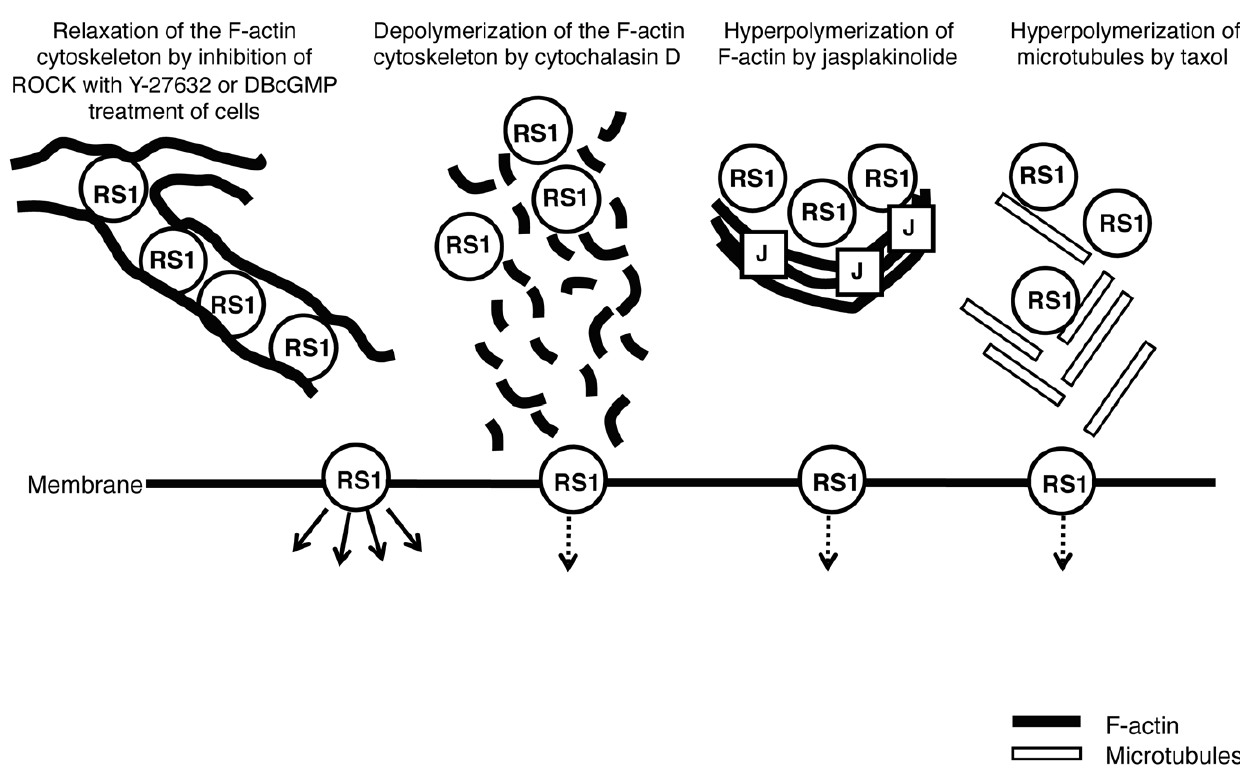
Figure 9. Summary diagram for the roles of the F-actin and microtubule cytoskeletons in retinoschisin secretion. Different pharmacological treatments of Weri-Rb1 cells showed that: The F-actin depolymerizing drug cytochalasin D causes fragmentation of F-actin and inhibits secretion of retinoschisin in a dose-dependent manner at concentrations higher than 0.5 m M. At 2 m M cytochalasin D, this inhibition of secretion results in a 2.1-fold accumulation of retinoschisin within the cultured cells. The natural toxin Jasplakinolide (1 m M) hyperpolymerizes F-actin and results in the reduction of retinoschisin secretion and its 2.9-fold accumulation within the cells. Inhibition of ROCK using 20 m M Y-27632 or treatment with 2 mM DBcGMP relaxes the F-actin cytoskeleton and almost doubles retinoschisin secretion. Hyperpolmerization of microtubules by taxol results in disorganized microtubule bundles that reduce retinoschisin secretion. The solid arrows indicate increased retinoschisin secretion and the dotted arrows, decreased secretion.